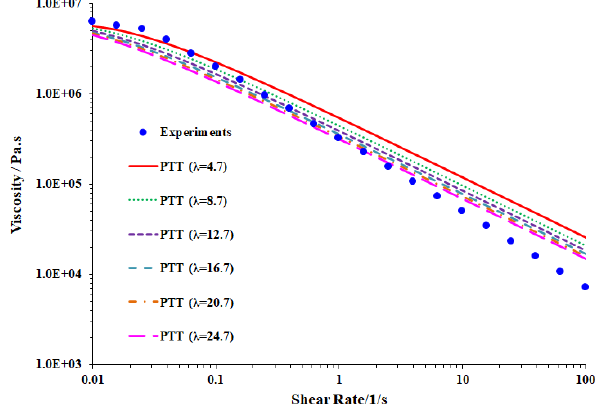
regions reached 49.79% and 50.51%, respectively, which exceeds the error permission of an ordinary simulation.